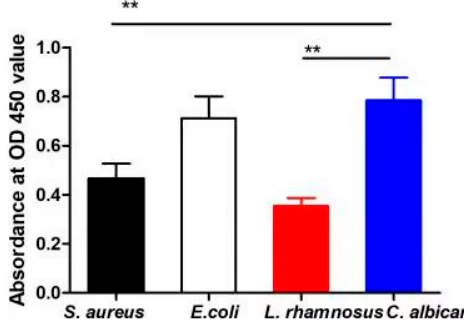
Figure 11. The binding affinity of P19 to the bacterial or fungal whole cells. ** p < 0.05.